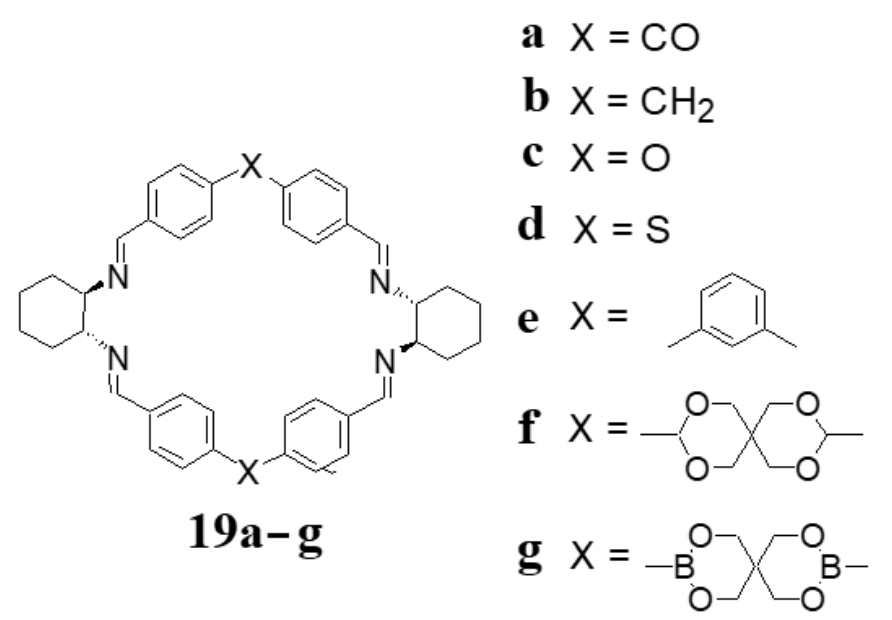
Figure 9. Examples of rhombimine macrocycles.